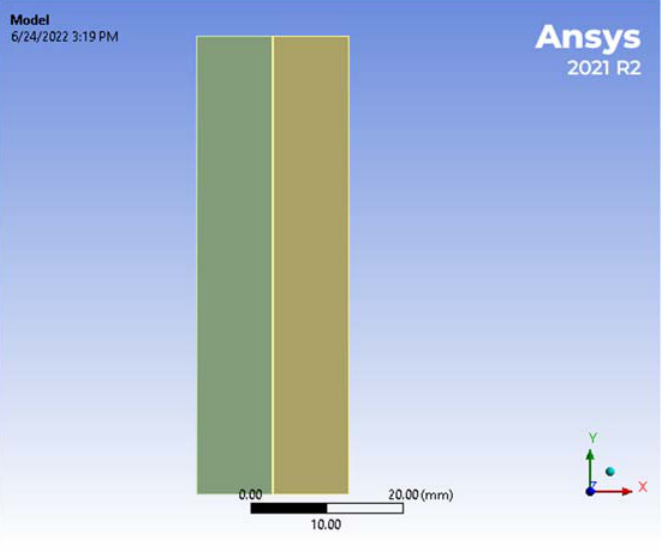
Figure 6. Model geometry for both the transient thermal and the transient structural simulations.